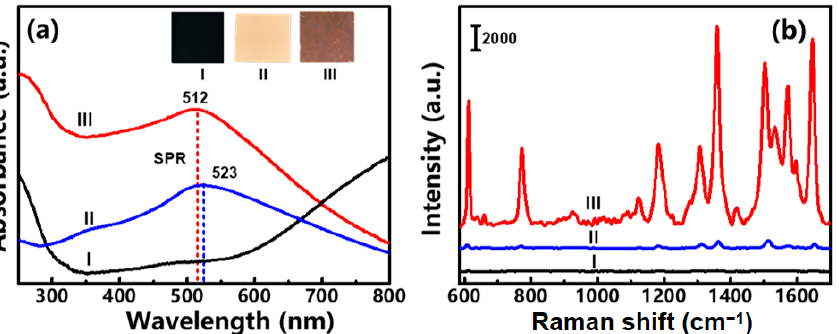
Figure 8. ( a ) Optical images and absorption spectra of the sensing substrates consisting of (I) CuS MFs, (II) Au NPs, and (III) Au/CuS hybrid MFs. ( b ) The acquired SERS spectra of substrates with exposure to 10 − 7 M R6G molecules.